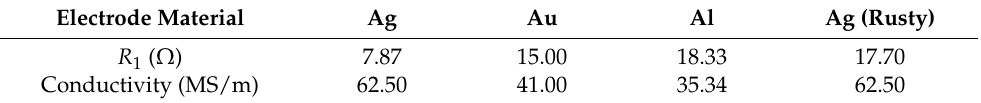
Table 4. Conductivity of the electrode materials and their motional resistance.